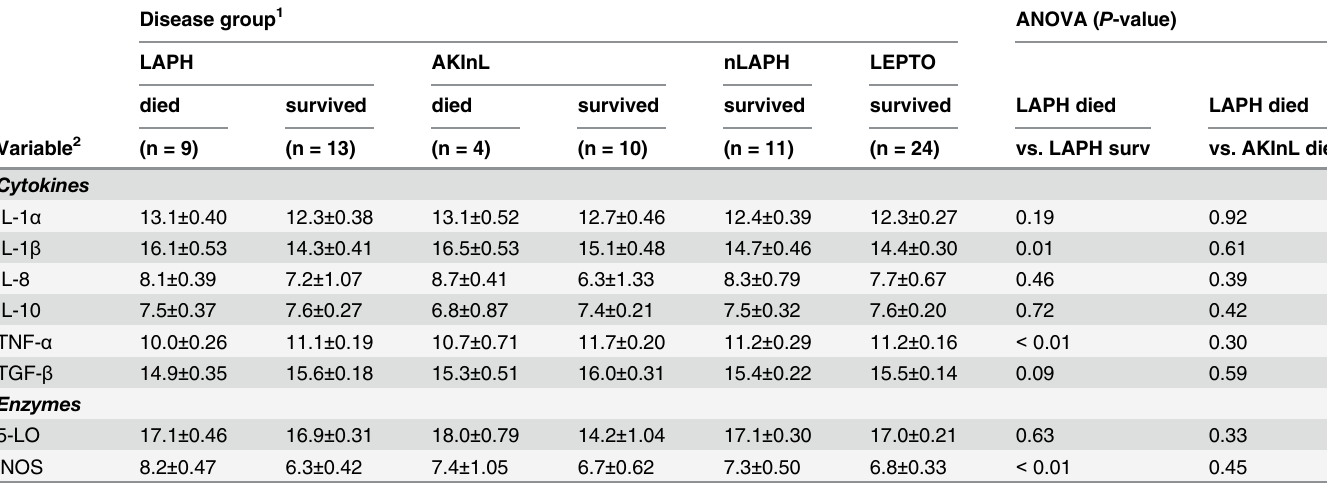
Table 4. Mean ± SEM of mRNA abundance (CT, log 2 ) of genes encoding cytokines and enzymes in blood of diseased dogs one day before or at the day of death compared to diseased dogs that survived corresponding in time. Disease group